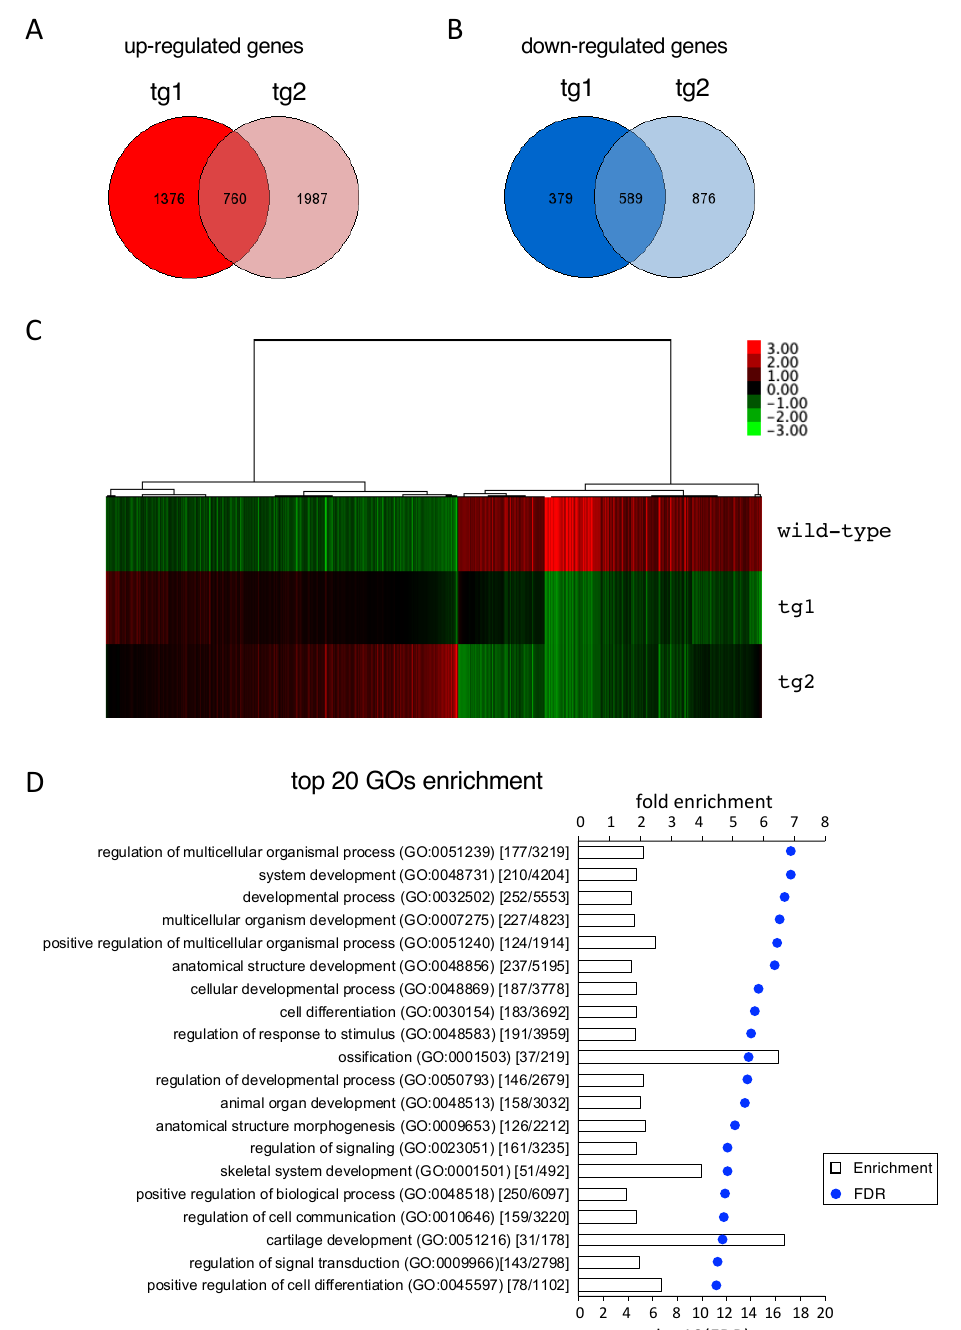
Figure 6. Microarray analysis. Microarray analysis was performed using one wild-type and two Hck CA tg (tg1 and tg2) samples. ( A and B ) Venn diagrams were drawn based on our microarray data sets. Red circles indicate the numbers of genes up-regulated in the tg group (vs. wild-type group, fold change ≥ 1.5) ( A ), and blue circles represent the numbers of down-regulated genes in the tg group (vs. wild-type group, fold change < 0.5) ( B ). The numbers in the overlapped regions reflect up-regulated or down-regulated genes in both tg1 and tg2 embryos compared with the gene expression in wild-type embryos. ( C ) Heatmap image of microarray data of the overlapped genes in A and B . Green indicates reduced expression and red indicates increased expression. ( D ) Top 20 of gene ontology (GO) enrichment (false discovery rate (FDR) < 0.05) of di ff erentially expressed genes are displayed in an ascending order of FDR. The numbers in the parentheses represent the gene count of matched term per number of genes in the reference